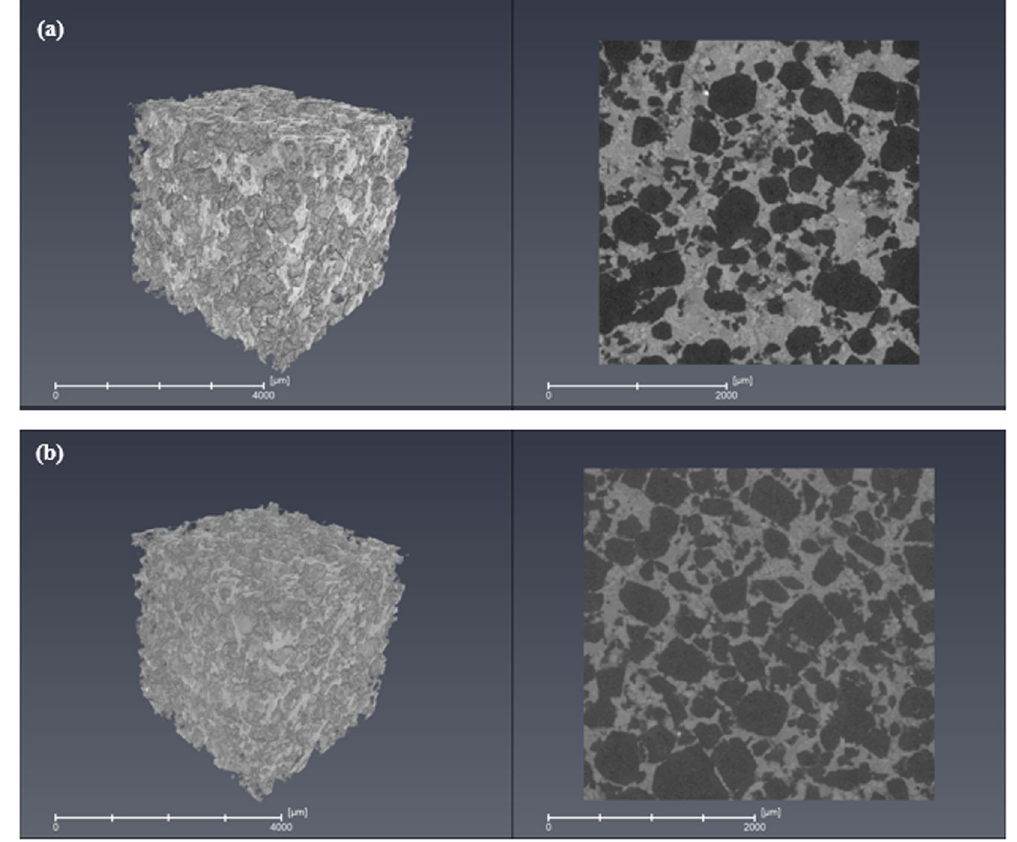
Figure 10. An X-ray micro tomography ( µ CT) image of S53B50 glass scaffold mixed with ( a ) 60 vol.% and ( b ) 70 vol.% NH